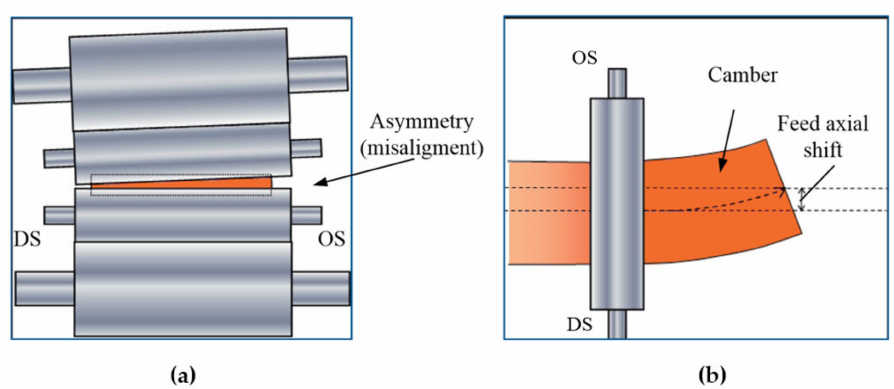
Figure 1. Asymmetry (misalignment) of roll gap ( a ), camber and feed axial shift ( b ). Horizontal bend is induced in the strip by strain difference in cross section (Figure